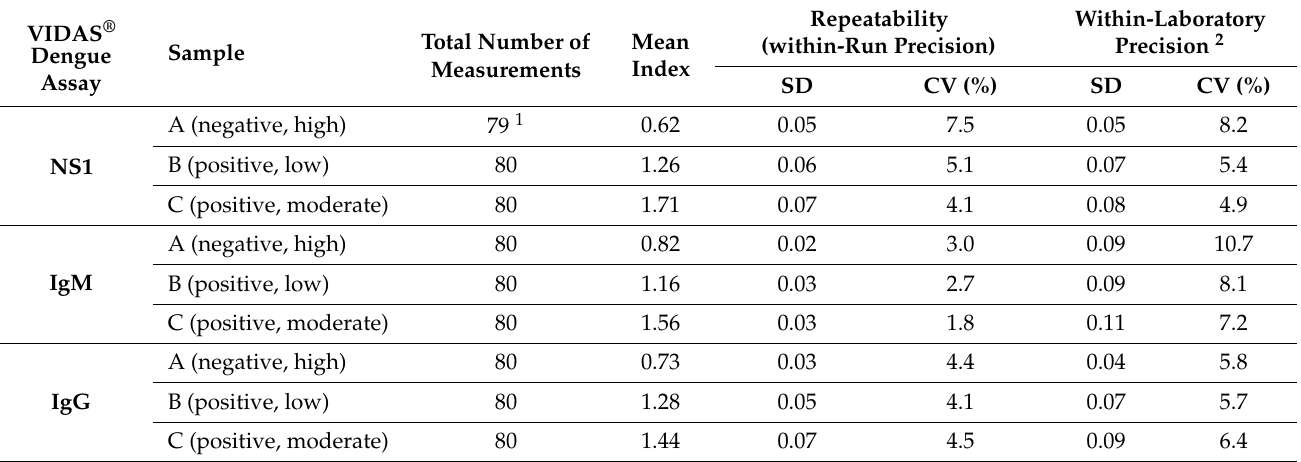
Table 5. Precision of the VIDAS ® Dengue NS1, IgM and IgG